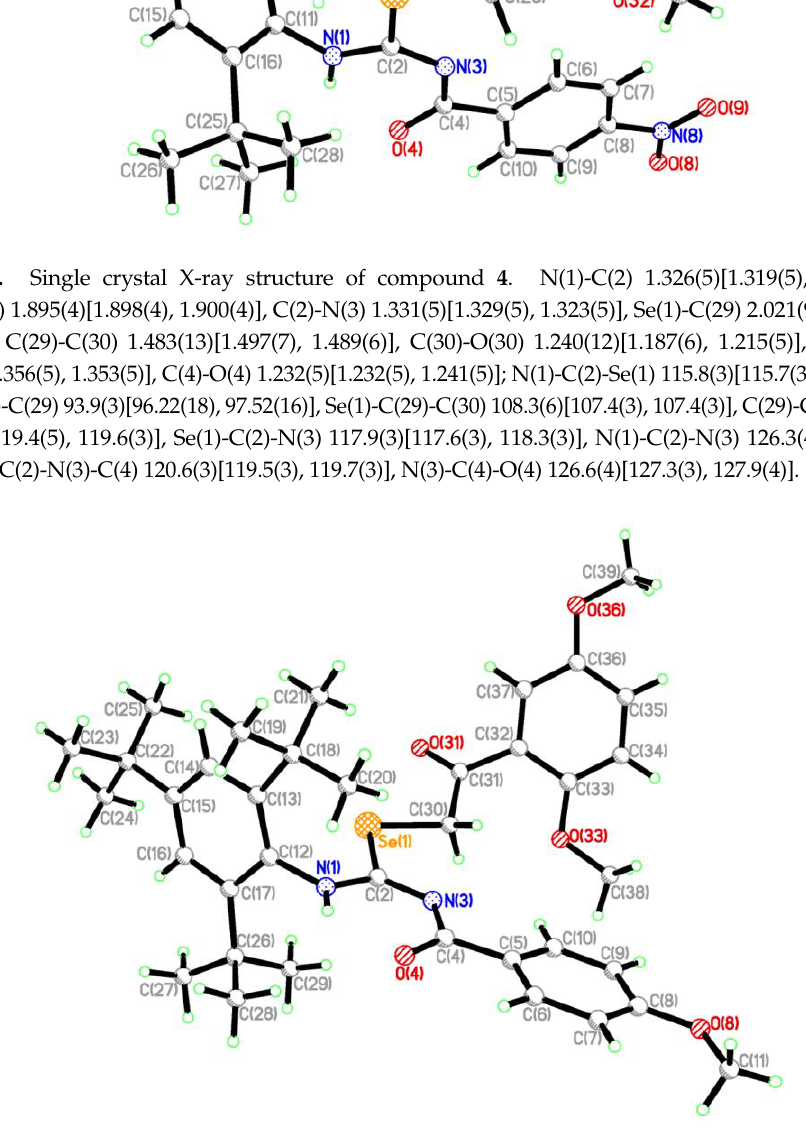
Figure 6. Single crystal X-ray structure of compound 6 . N(1)-C(2) 1.327(3), C(2)-Se(1) 1.918(3), Se(1)-C(30) 1.945(3), C(30)-C(31) 1.496(4), C(31)-O(31) 1.220(3), C(2)-N(3) 1.319(3), N(3)-C(4) 1.362(3), C(4)-O(4) 1.239(3); N(1)-C(2)-Se(1) 114.49(18), N(1)-C(2)-N(3) 127.3(2), C(2)-Se(1)-C(30) 95.82(11), Se(1)-